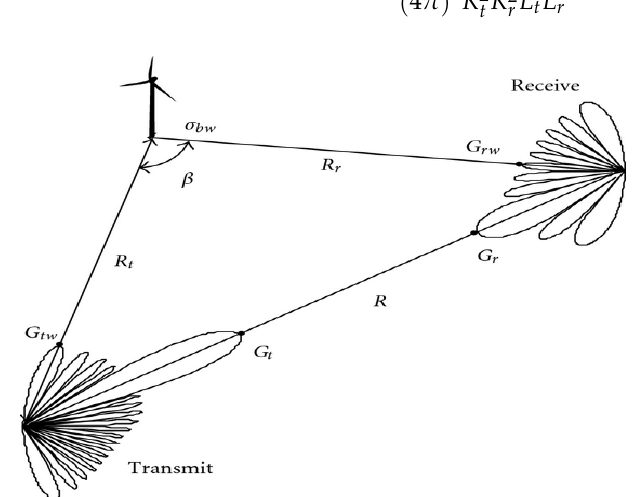
Figure 13. Parameters of the Bistatic Case